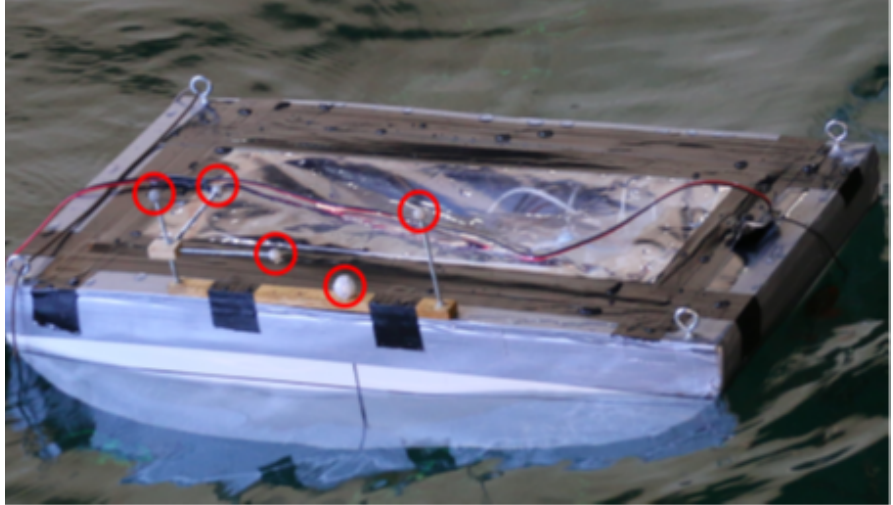
Figure 9. Setup of Qualysis motion tracking system markers mounted on the device